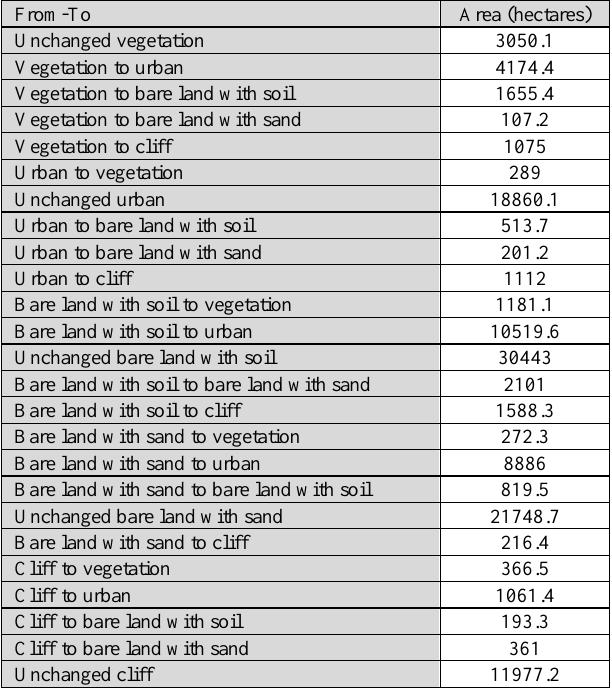
Table 8. From-To change